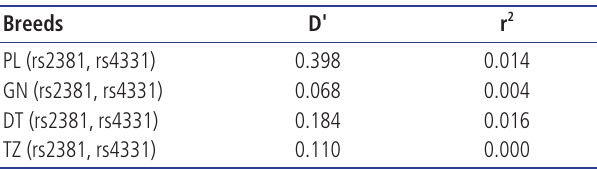
Table 8. Analysis of linkage disequilibrium of the two polymorphisms in the four yak breeds Breeds D' r 2 PL (rs2381, rs4331) 0.398 0.014 GN (rs2381, rs4331) 0.068 0.004 DT (rs2381, rs4331) 0.184 0.016 TZ (rs2381, rs4331) 0.110